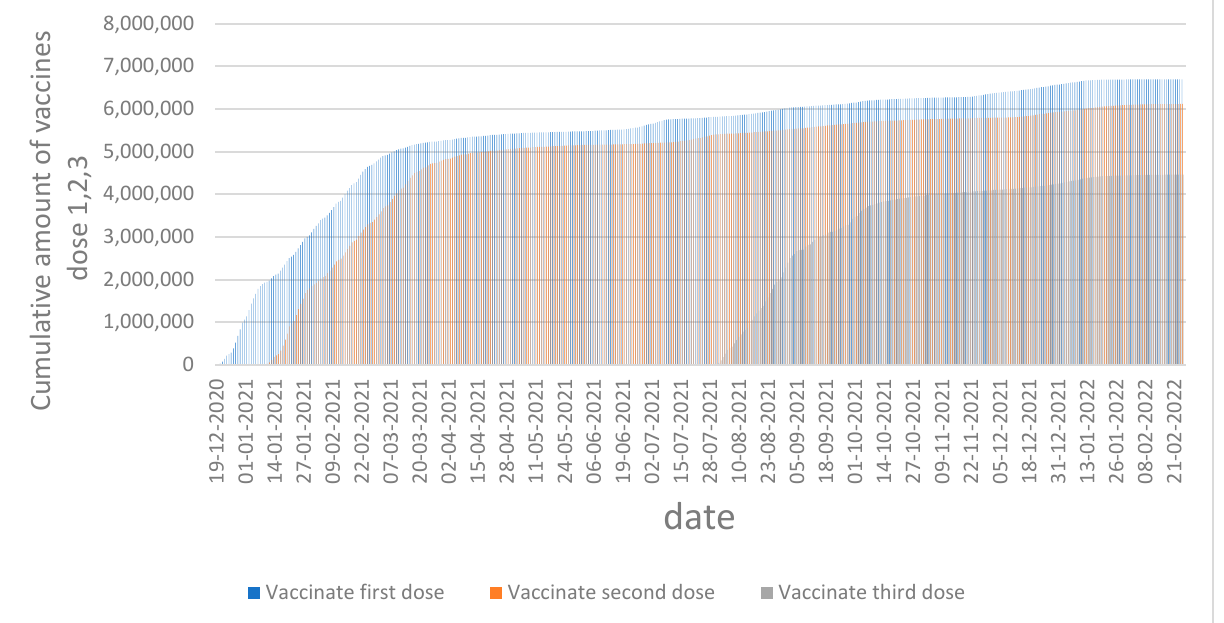
Figure 2. Cumulative amounts of vaccine doses 1, 2, and 3 by date in Israel.